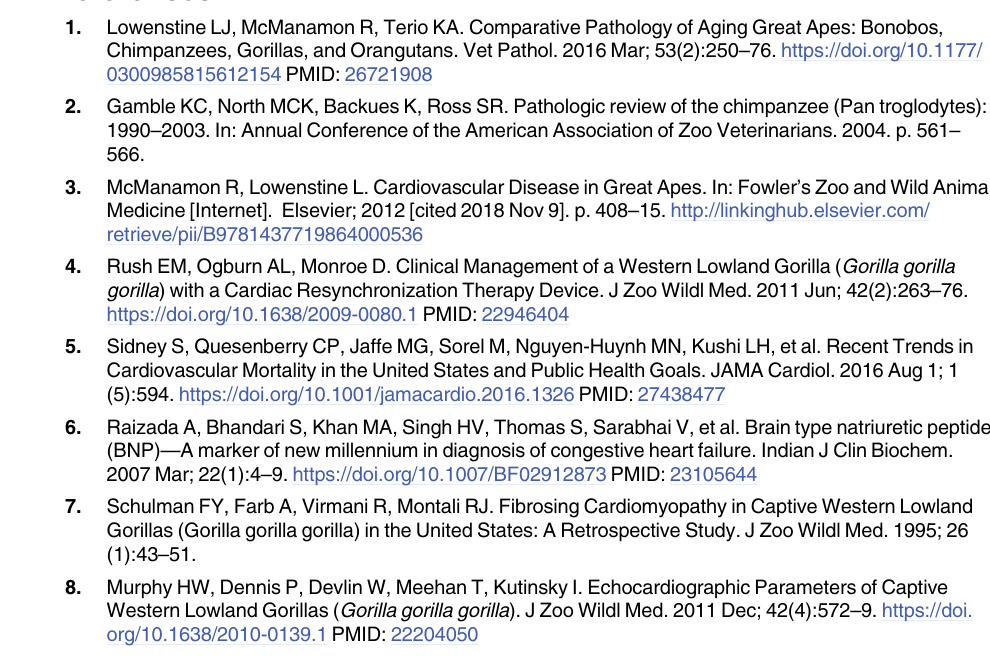
S5 Fig. Age and echocardiographic findings for gorillas with health status “3”. Histogram plots with normal curves applied depicting gorillas assigned a health status of “3”: a) age (years); b) interventricular septal end diastole–IVSd (cm); c) left ventricular internal diameter end diastole–LVIDd (cm); d) left ventricular posterior wall diastole–LVPWd (cm); and e) ejec- tion fraction–EF (%). (ZIP) S1 Table. Raw data used for statistical evaluation of all gorillas.